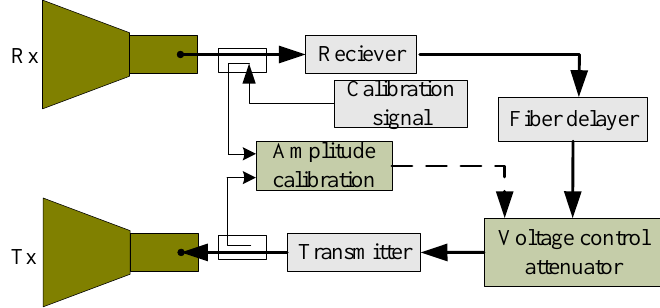
Figure 7. Amplitude calibration circuit scheme.